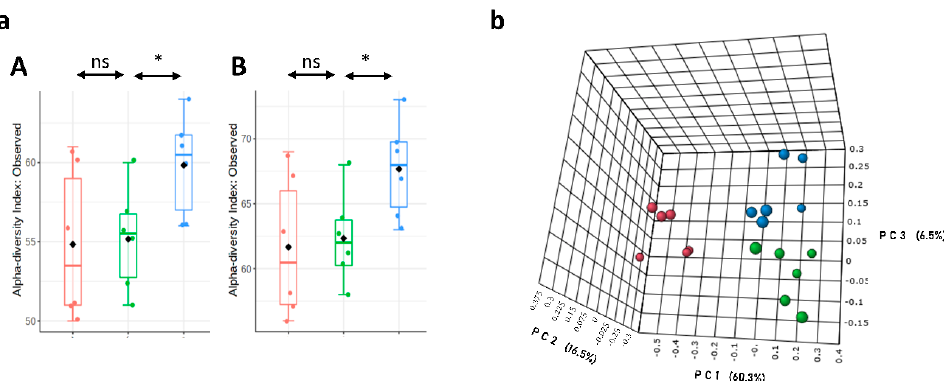
Figure 5. L.p DSM20174 modified the diversity of gut microbiota. ( a ) Alpha diversity, measured by observed genera ( A ) and species ( B ) in faecal samples of ND, HFHF, and HFHF + L.p mice. Mean values and interquartile ranges are indicated in the plots. ( b ) Beta-diversity (mean of different genera within mice). * Significant difference between HFHF and HFHF + L.p ( p < 0.05). Red boxes and circles represent the ND group, green boxes and circles represent the HFHF group, and blue boxes and circles represent the HFHF + L.p group ( n = 6 mice per each group).